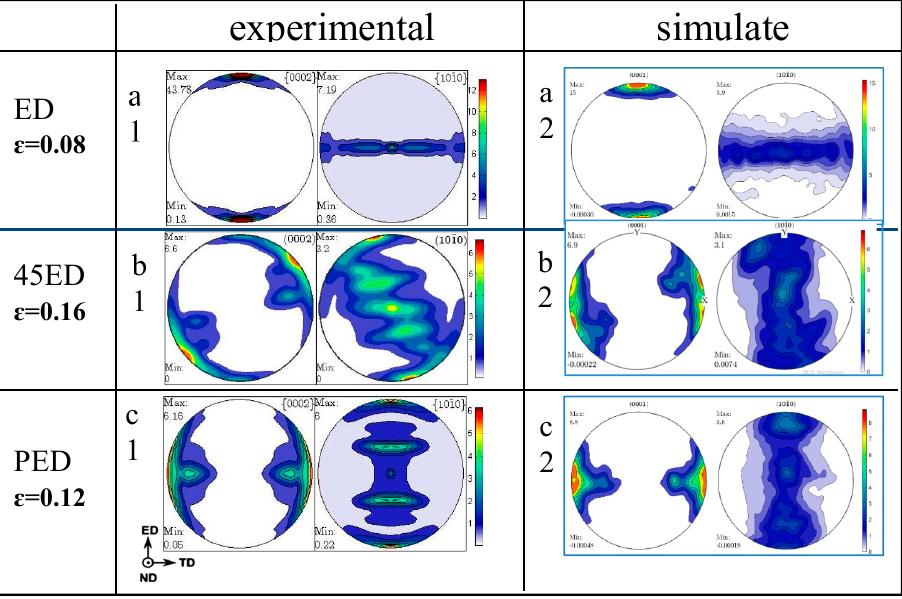
Figure 4. Measured ( left ) and simulated ( right ) pole figures of various AZ31 alloys samples under Fig.4 Measured (left) and simulated (right) pole figures of various AZ31 alloys samples under 4 uniaxial uniaxial compression.